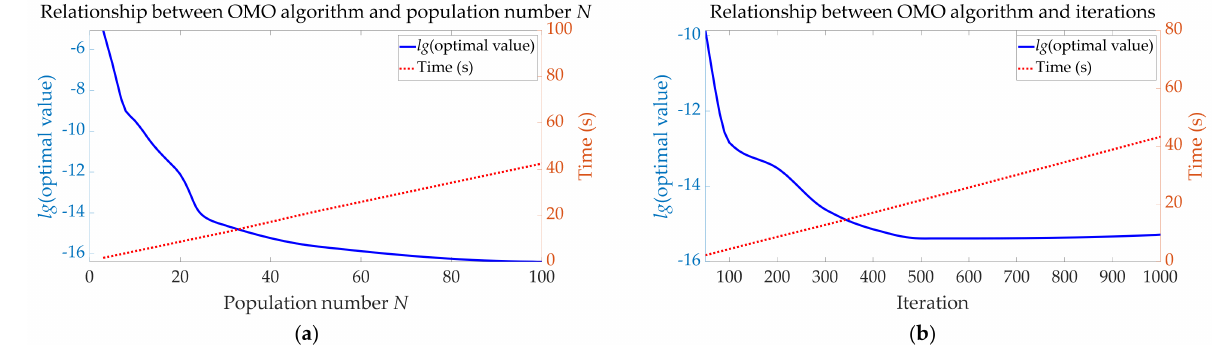
Figure 8. Relationship between OMO algorithm and population number N or iterations. ( a ) Smooth curve graph of the population number N —the optimal value of the objective function and the population number N —the consuming time; ( b ) smooth curve graph of the iterations—the optimal value of the objective function and the iterations—the consuming time.